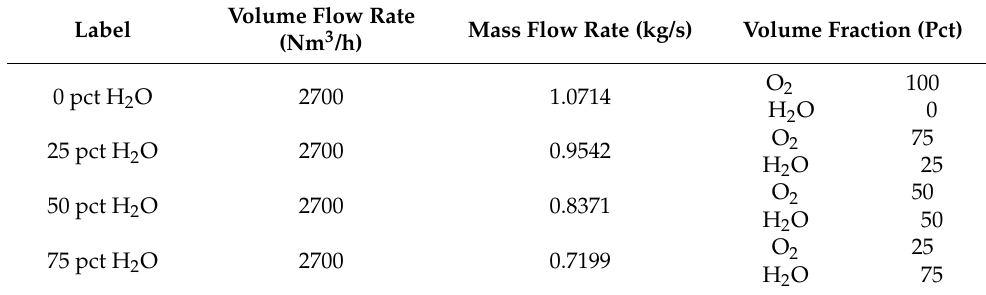
Table 2. Experimental scheme of main gas